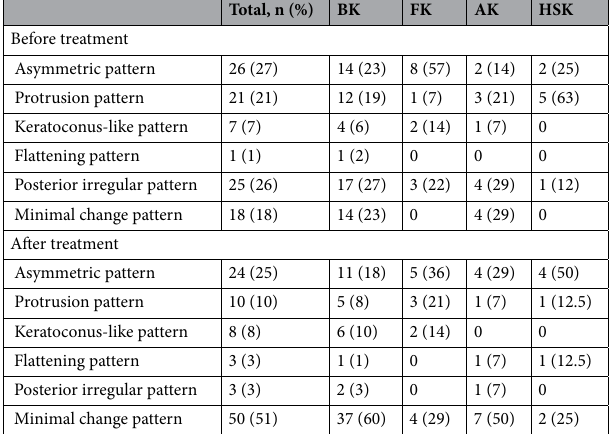
Table 4. Corneal topographic map patterns before and after treatment. AK Acanthamoeba keratitis, BK bacterial keratitis, FK fungal keratitis, HSK herpes simplex